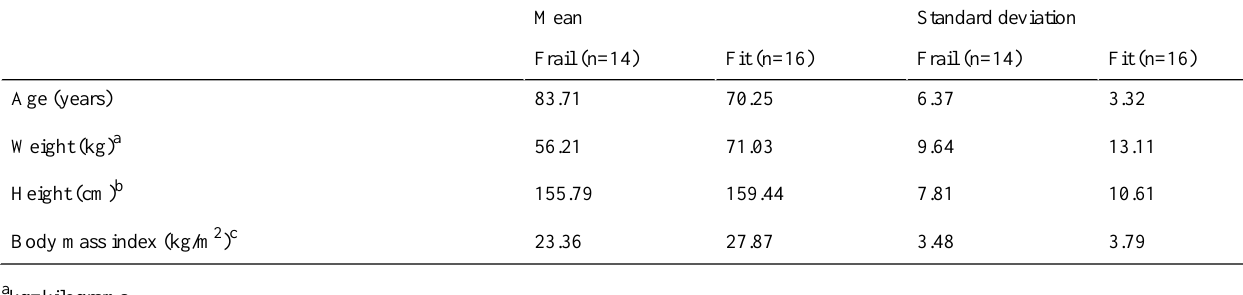
Table 1. Characteristics of sample (N=30).